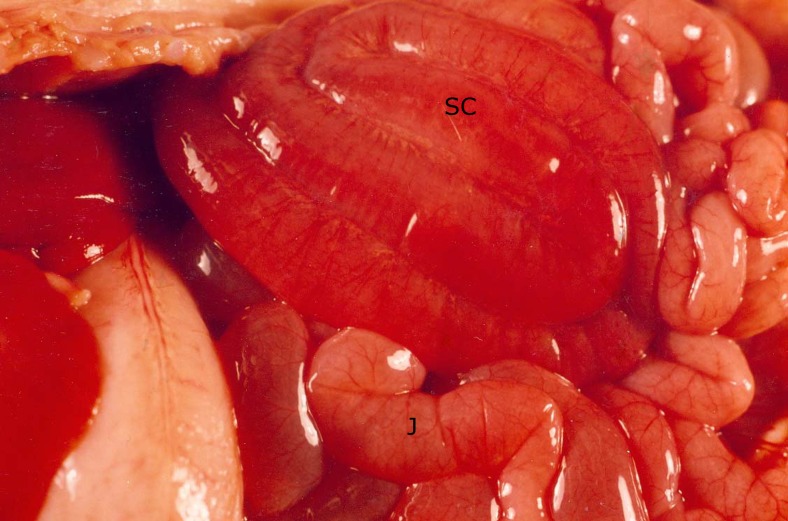
Photograph at necropsy of piglet 15 h after inoculation with enterotoxigenic E. coli strain 3030–2.Spiral colon (SC) is diffusely hemorrhagic, and jejunum (J) is hyperemic; both spiral colon and jejunum are distended with watery ingesta.